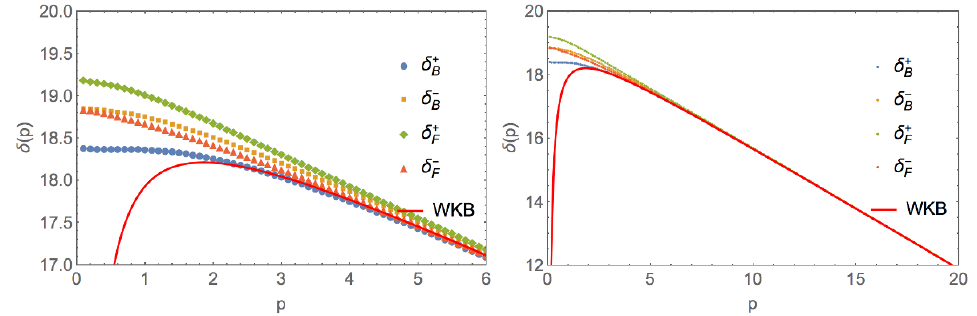
Figure 1 . Numerical results for the phaseshifts and the WKB approximation (E.8) as functions of p